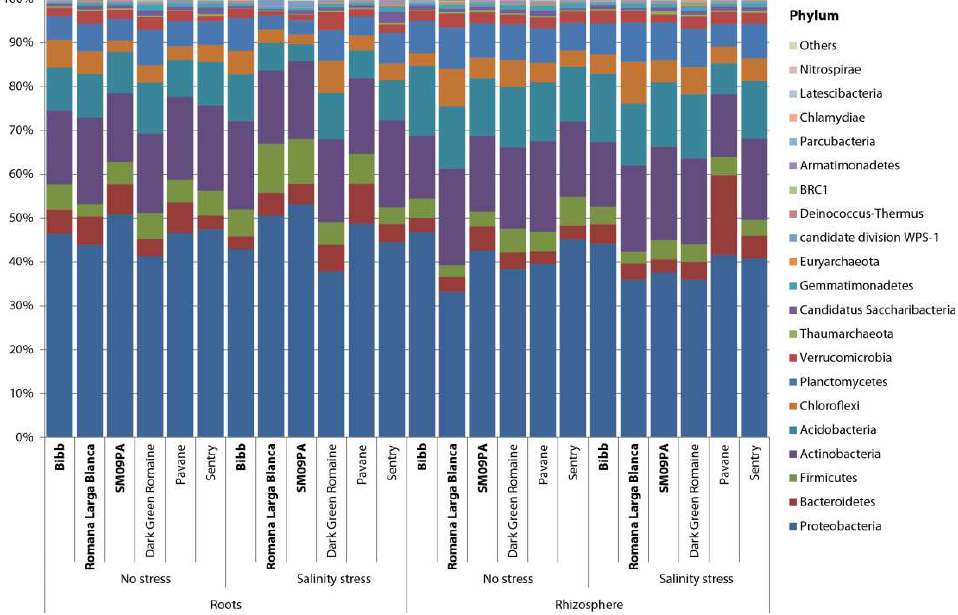
Figure 2. Bar chart of bacterial phyla composition in roots and rhizosphere of six lettuce varieties in normal conditions and under salinity stress.